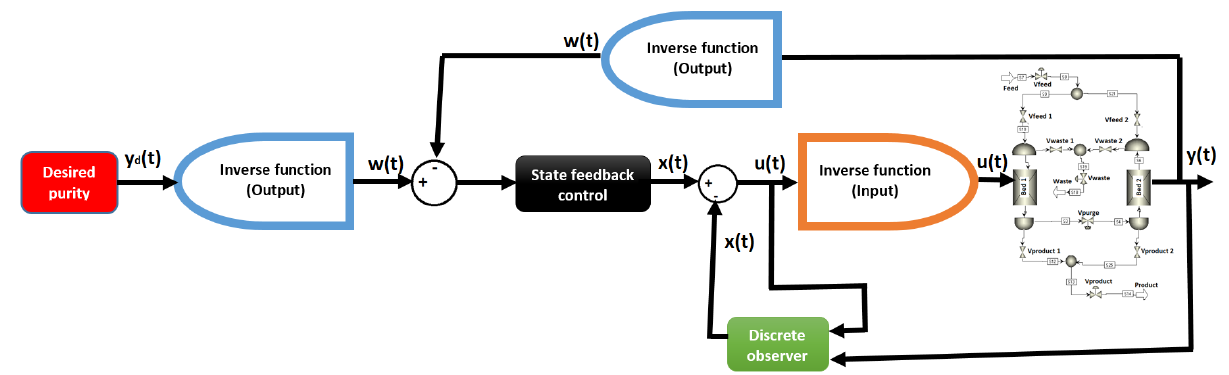
Figure 17. Validation of state feedback control in the PSA process.